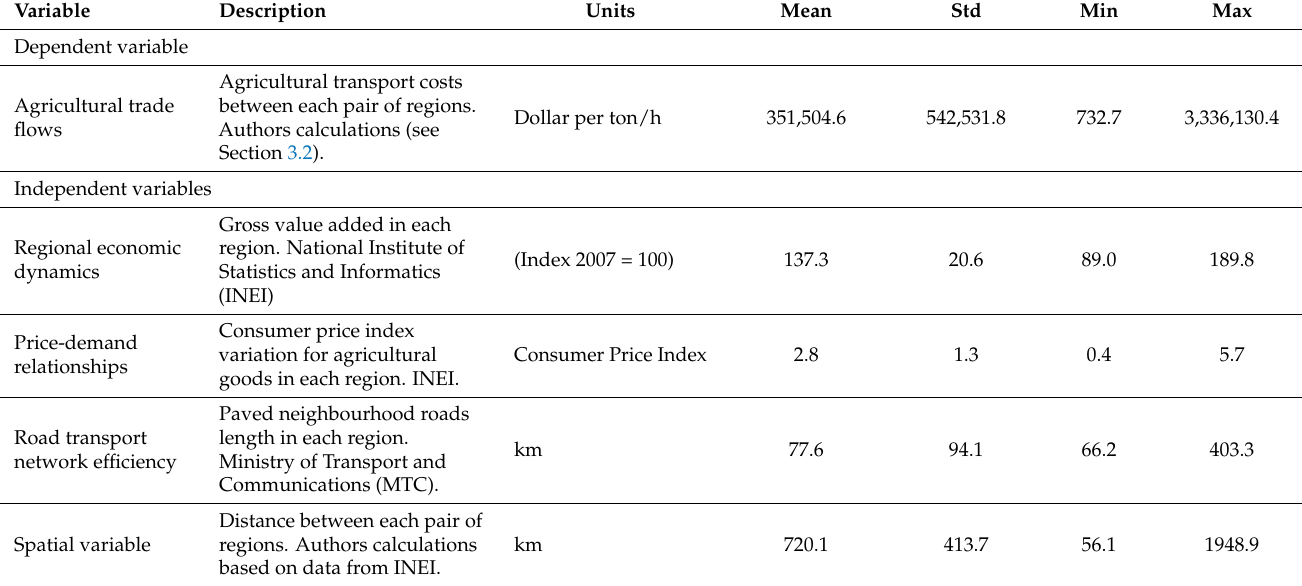
Table 3. Description of the dependent and independent variables.